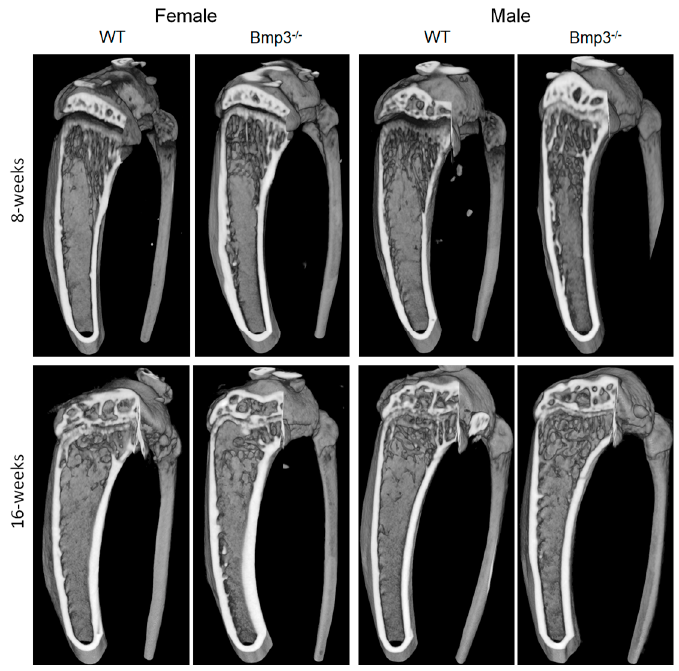
Figure 6. Tibia cortical and trabecular bone render of 8-week- and 16-week-old female and male Bmp3 − / − and WT mice.